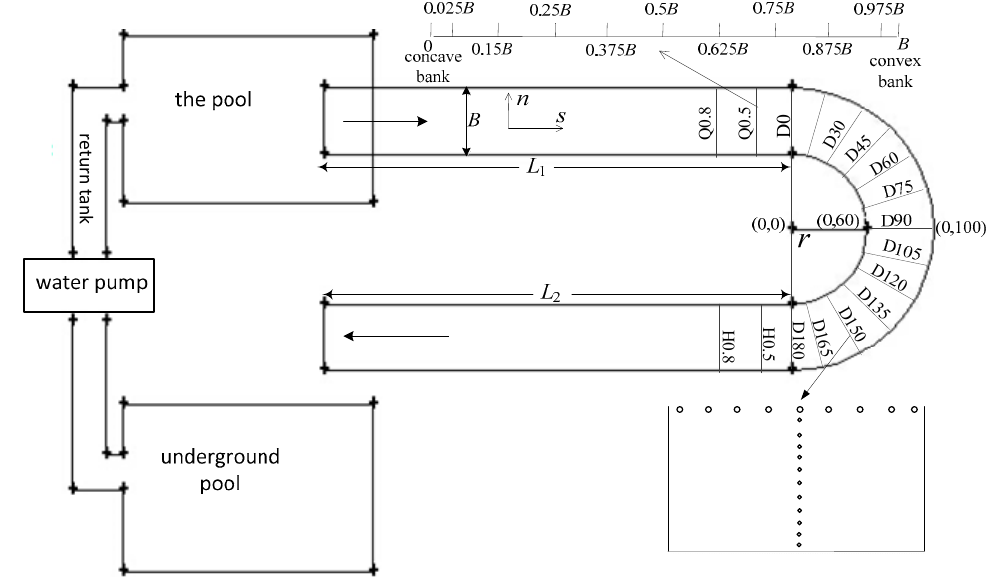
Figure 1. The model of U-shape curve.